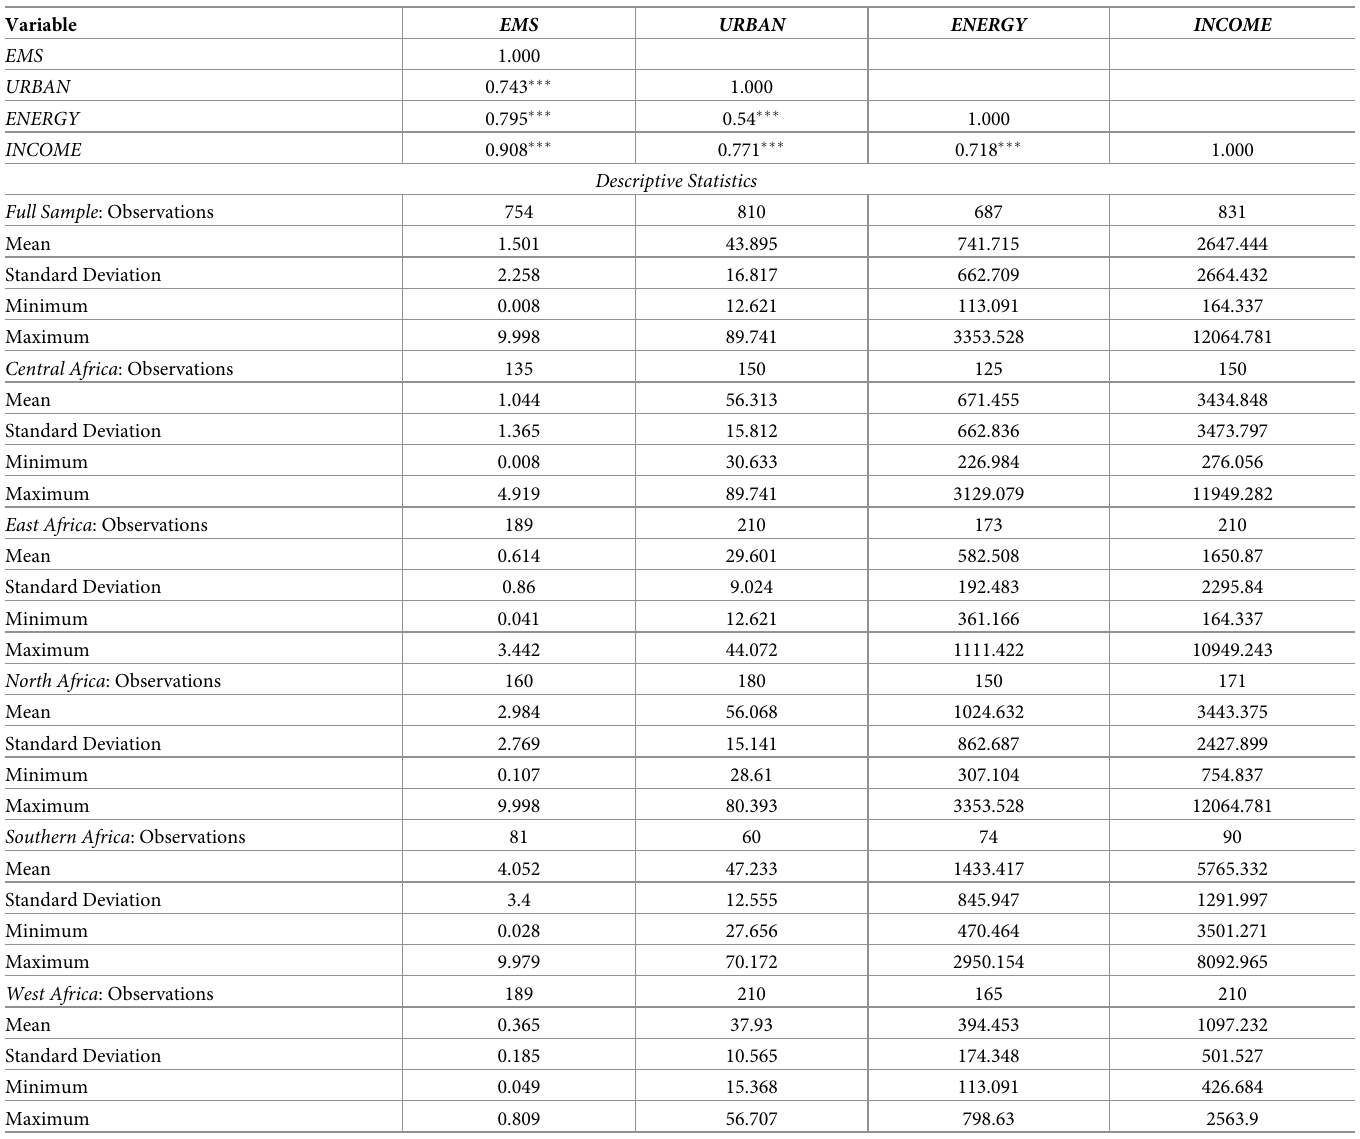
Table 1. Correlation analysis and summary